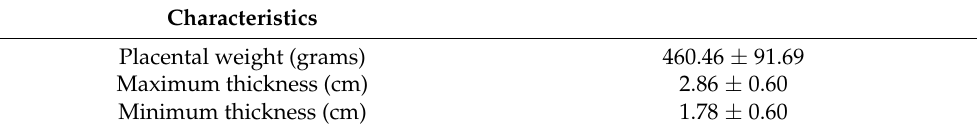
Table 2. Macroscopical characteristics of the placentas in patients affected by SARS-CoV-2 infection.